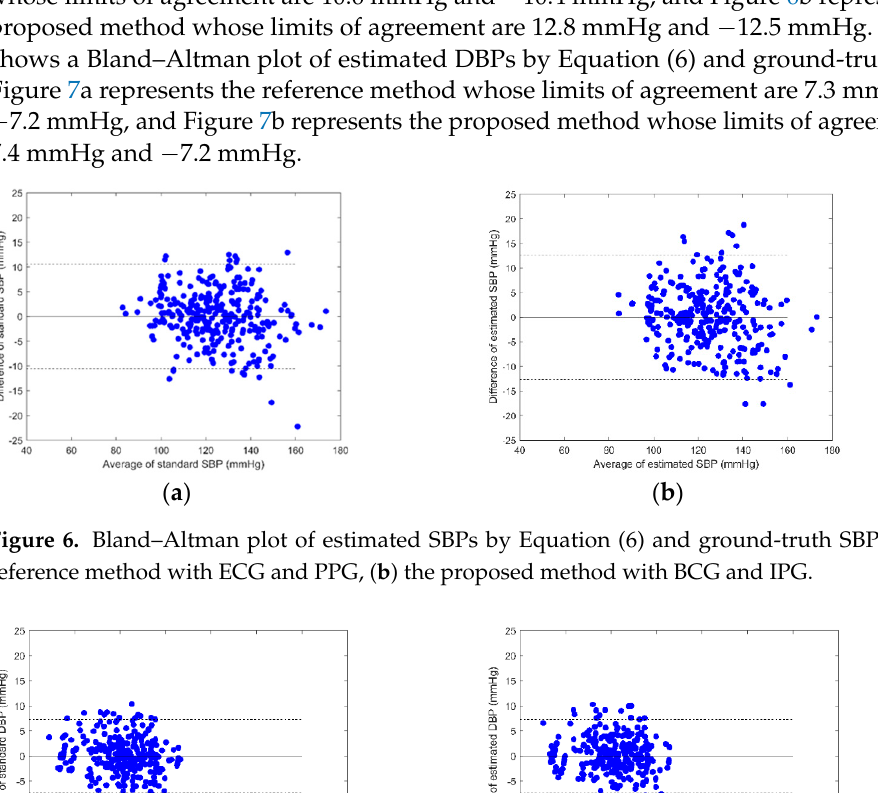
Table 6. The statistic of PTT1 and PTT2 measured by the reference and proposed methods.